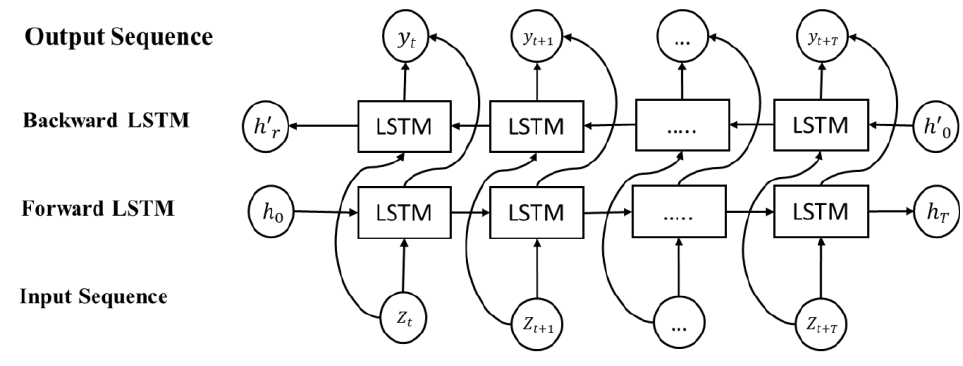
Figure A4. Basic Architecture of a Bi-LSTM.